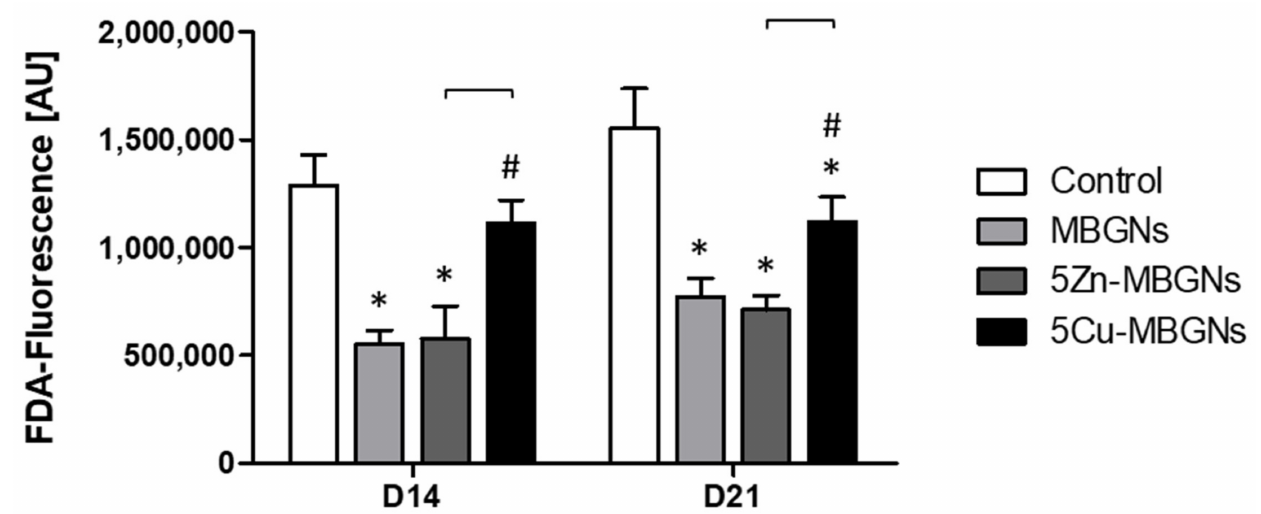
Figure 1. Viability of human bonemarrow-derived mesenchymal stromal cells (BMSCs). Significant differences compared to the control group are marked with (*), significant differences compared to mesoporous bioactive glass nanoparticles (MBGNs) with (#). Significant differences between the ion-doped MBGNs are highlighted with